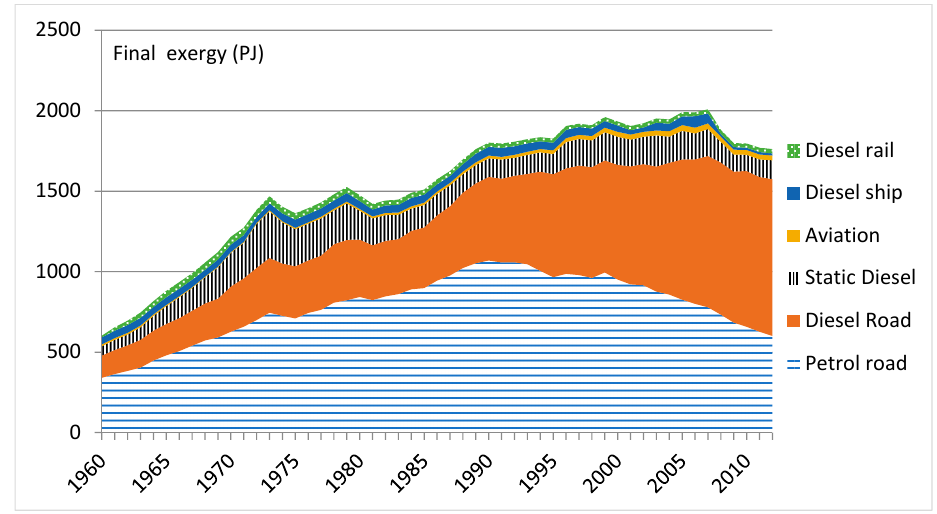
Figure 4. Final exergy allocated to mechanical drive end-uses. Table 2. Mechanical drive efficiency assumptions.